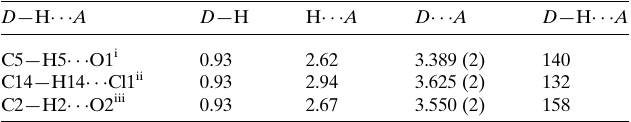
Table 3 Experimental details.